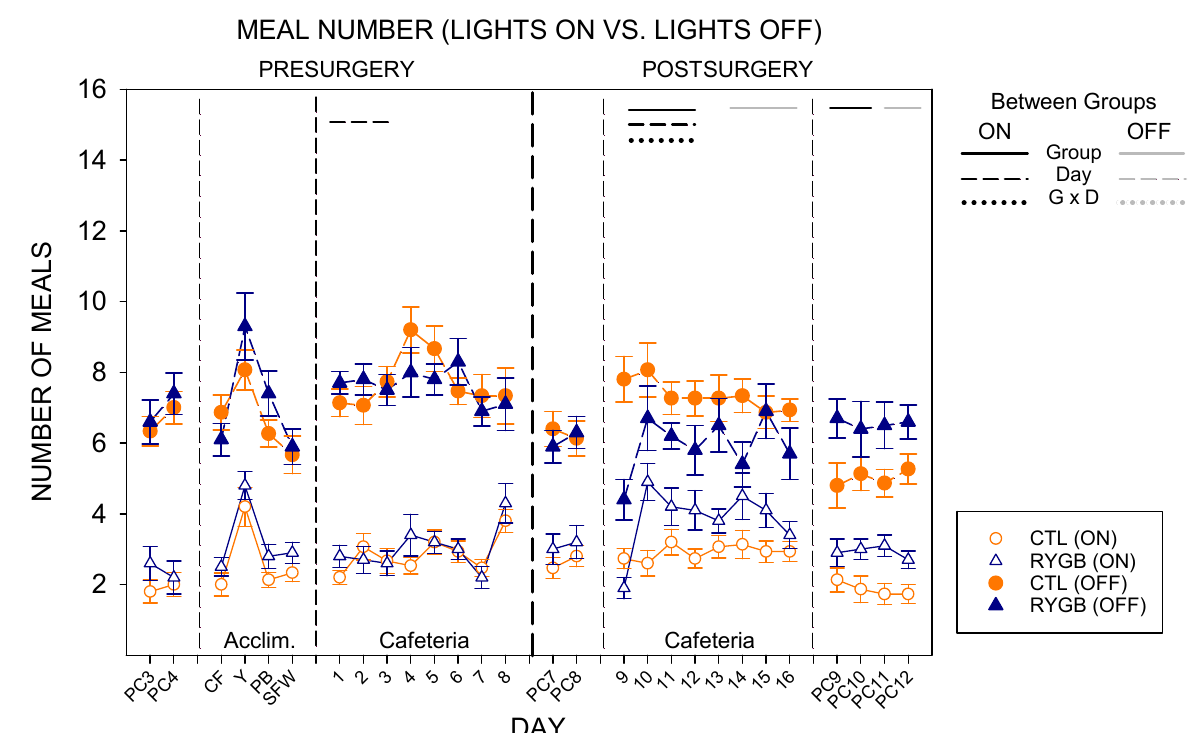
Figure 14. Meal Number for Meals with Lights On vs. Lights Off. Average (±SE) meal number when lights were on (open symbols) or off (filled symbols) for each day for CTL (combined SHAM and IRON groups, n = 14; orange circles) and RYGB ( n = 11; blue triangles) rats for powdered chow days (PC), acclimation days for each food (Acclim.; CF: chickpea flour; Y: yogurt; PB: peanut butter; SFW: sugar/fat whip), and cafeteria diet days. Dashed vertical lines indicate transitions between diet conditions (thin dashed) and between pre- and postsurgical phases (thick dashed). Statistically significant results from between-group two-way mixed ANOVAs (Table 16) are indicated by the legend; within-group ANOVA results are presented in Table 17. Table 16. Two-way ANOVAs Comparing Meal Number for Lights-On and Lights-Off Meals between Groups for Each Diet Condition.